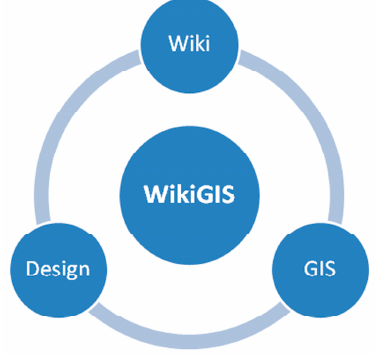
Figure 1. WikiGIS = Wiki + GIS +